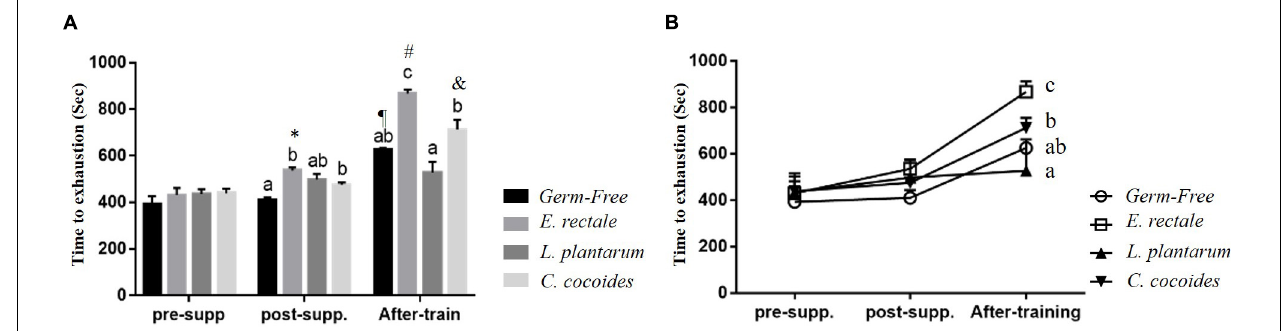
FIGURE 3 | Effect of 6-week indicated microbe supplementation on exercise capacity. Exercise endurance at different time points (A) and Exercise endurance profile (B) . Data are mean ± SEM ( n = 6–8/group). Columns with different superscript letters (a,b) are significantly different at P < 0.05 at the same time point. ∗ P < 0.05, compared within E. rectale group (pre-supp vs. post-supp). ¶ P < 0.05, # P < 0.05, and & P < 0.05 compared within GF, E. rectale , and C. coccoides group (post-supp vs. after-train), respectively.